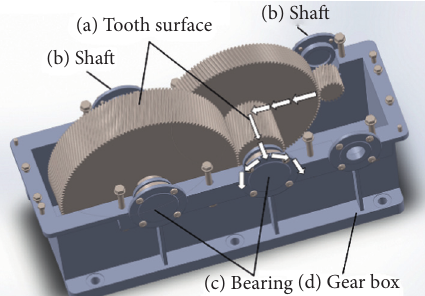
Figure 1: Schematic diagram of the first vibration transmission